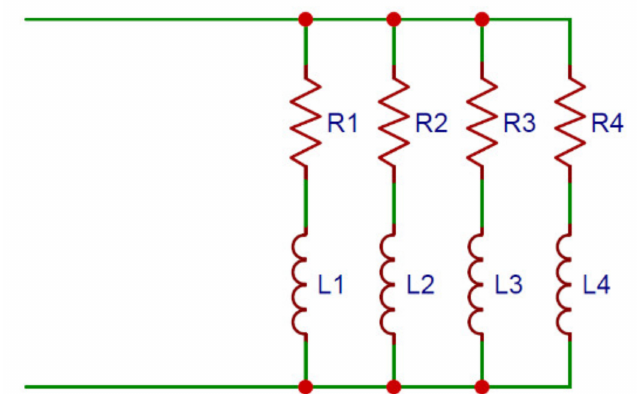
Figure 7. Serial { R , L } connection—parallel branches. Demonstration of Theorem